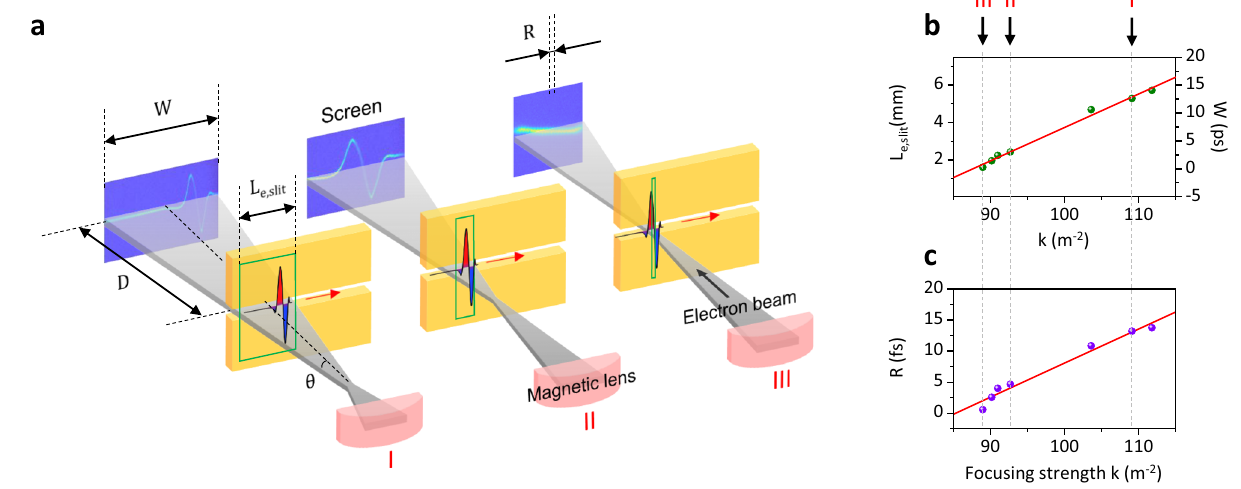
k ) of the electron beam is controlled by the applied